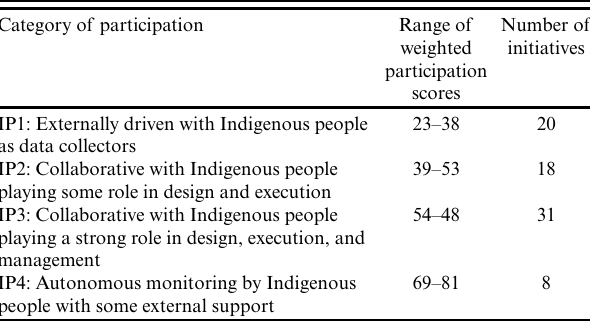
Table 4 . Number of initiatives within each category